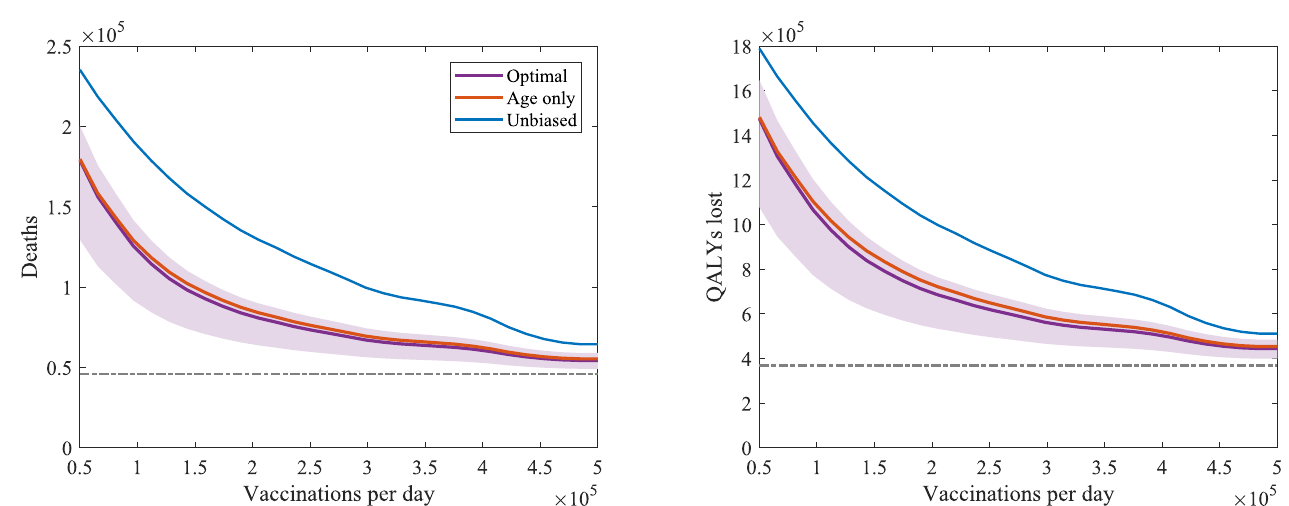
Fig 8. The total number of (left) deaths and (right) QALYs lost following the start of vaccination vs speed of deployment for a type 1 vaccination with 70% uptake and 70% efficacy. Vaccine deployment is started 2 months after stricter NPIs are relaxed to leave low level measures sufficient to keep R � 1.8. The purple line (and shaded prediction region) represents projected outcomes under the identified optimal ordering with age and comorbidity groups, the orange line outcomes using the identified optimal ordering accounting for age groups only (without comorbidity), and the blue line outcomes with an unbiased population wide delivery. The grey dotted lines show the base level of mortality or QALYs lost, as applicable, from the first wave of the pandemic in the UK in the first half of 2020.